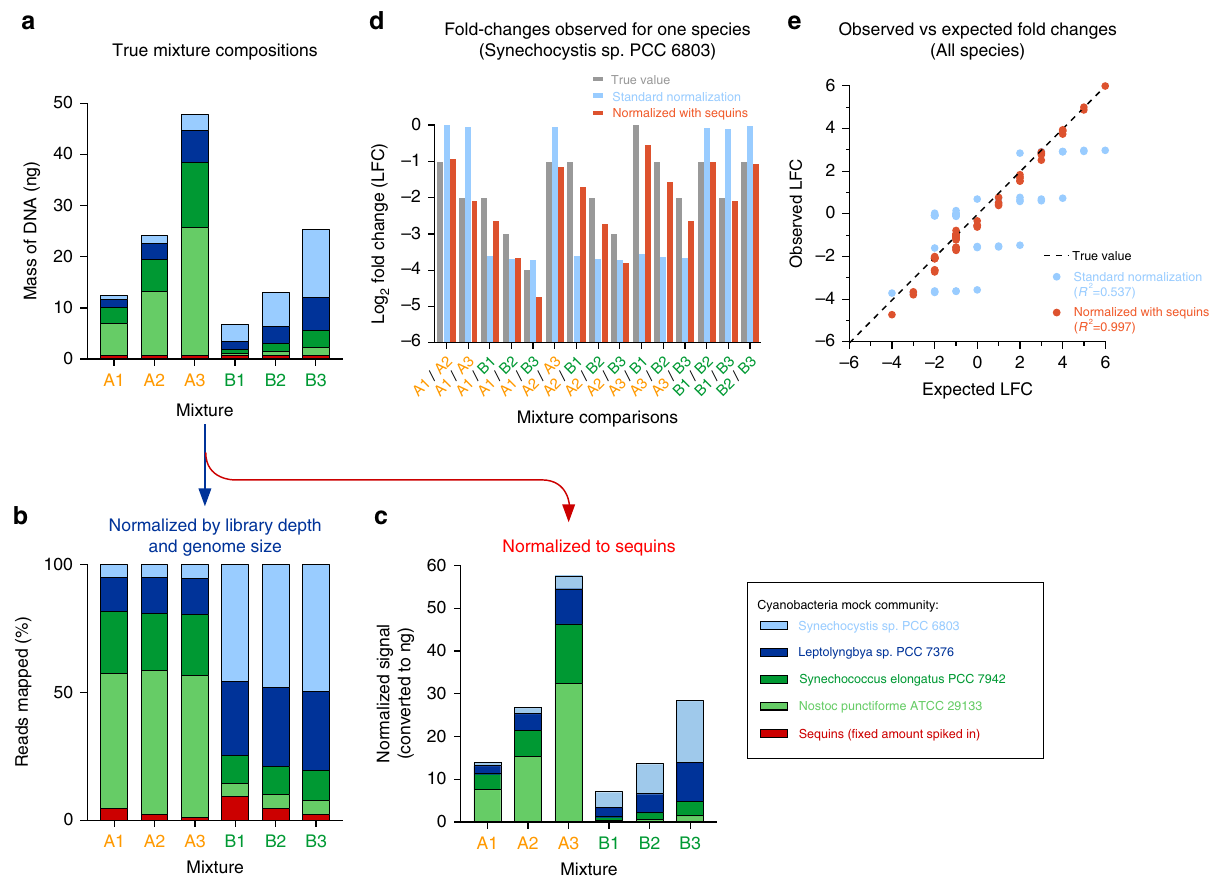
Fig. 4 Using sequins to accurately resolve both relative and absolute changes in microbial load. a We assembled six mock microbial mixtures comprising different amounts of four distinct cyanobacteria species. A fi xed (as opposed to fractional) amount of sequins (red) was added to each mixture. b Normalizing on the basis of library depth and genome size enabled the fractional composition of each mixture to be accurately measured; however, Mixes A1, A2, and A3 were indistinguishable from each other (likewise for Mixes B1, B2, and B3). However, as the amount of microbial DNA increased, the fraction of reads aligning to sequins decreased concomitantly. c By dividing the fractional abundance of each species by the fraction of reads aligned to sequins in each mixture, this enabled each sample ’ s reference point to be rescaled, thereby allowing the accurate resolution of both relative and absolute abundance. d We tracked the fold changes observed for the Synechocystis sp. PCC 6803 genome across the six mixtures, providing 15 separate fold change comparisons, including both relative and absolute abundance shifts. Bar graph shows the log 2 fold changes (LFC) observed after performing normalization on the basis of genome size and library depth (blue), and after carrying out additional normalization with sequins (red). The true LFC value is shown in gray. e Scatter plot shows the measured LFC for each species plotted against the expected LFC (a total of 60 comparisons). R 2 value indicates the correlation coef fi cient obtained after carrying out linear regression